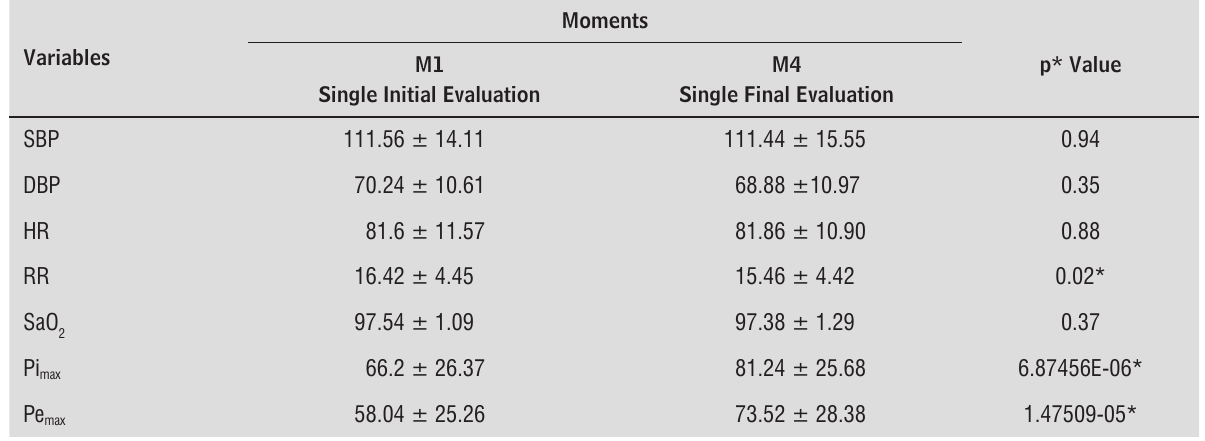
Table 3 - Comparison of cardiorespiratory variables achieved by a single evaluation between M1 and